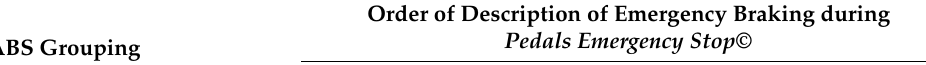
Table 1. Participant groupings based on ABS experience and order of the description of emergency braking during the Pedals Emergency Stop© exercise. Order of Description of Emergency Braking during Pedals Emergency Stop© ABS Grouping Before After the First Attempt 16 No knowledge and experience